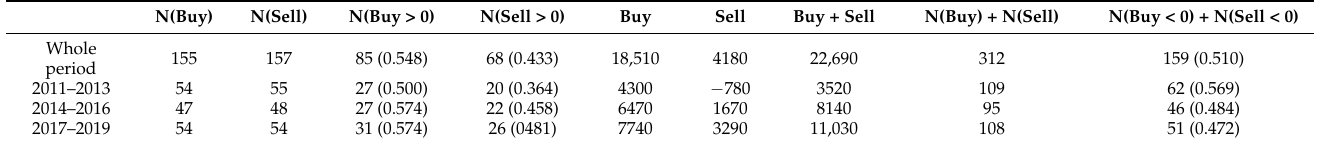
Table 4. The Performance of the MACD (4,22,3) Model with the 30%-Line of the 10-Day Crossover Strategy. N(Buy)